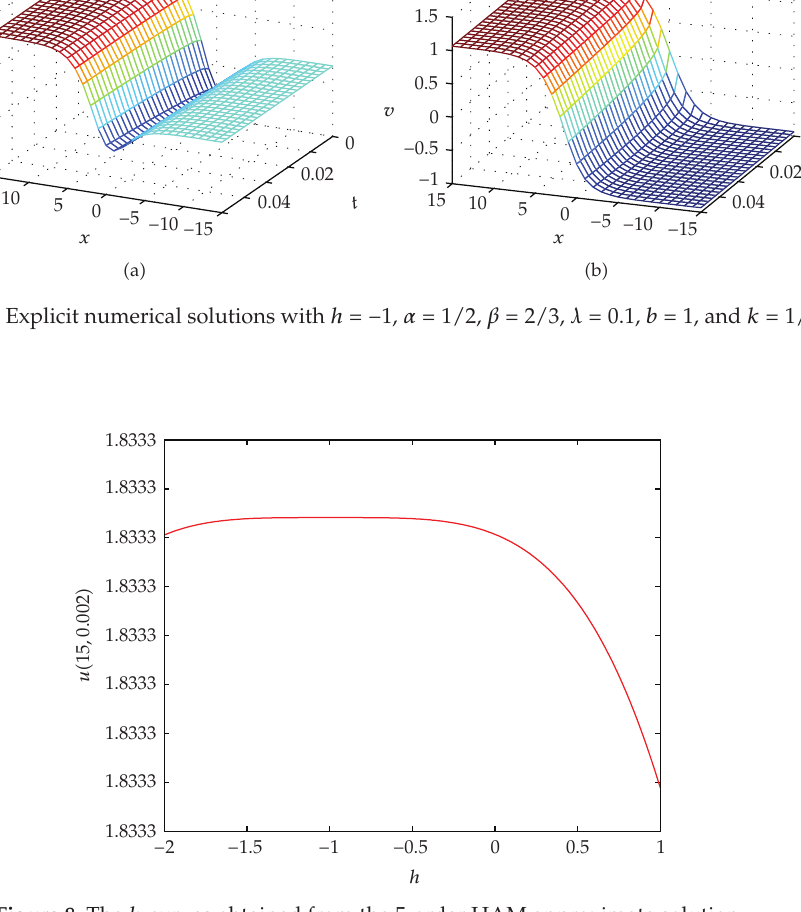
Figure 8: The h -curves obtained from the 5-order HAM approximate